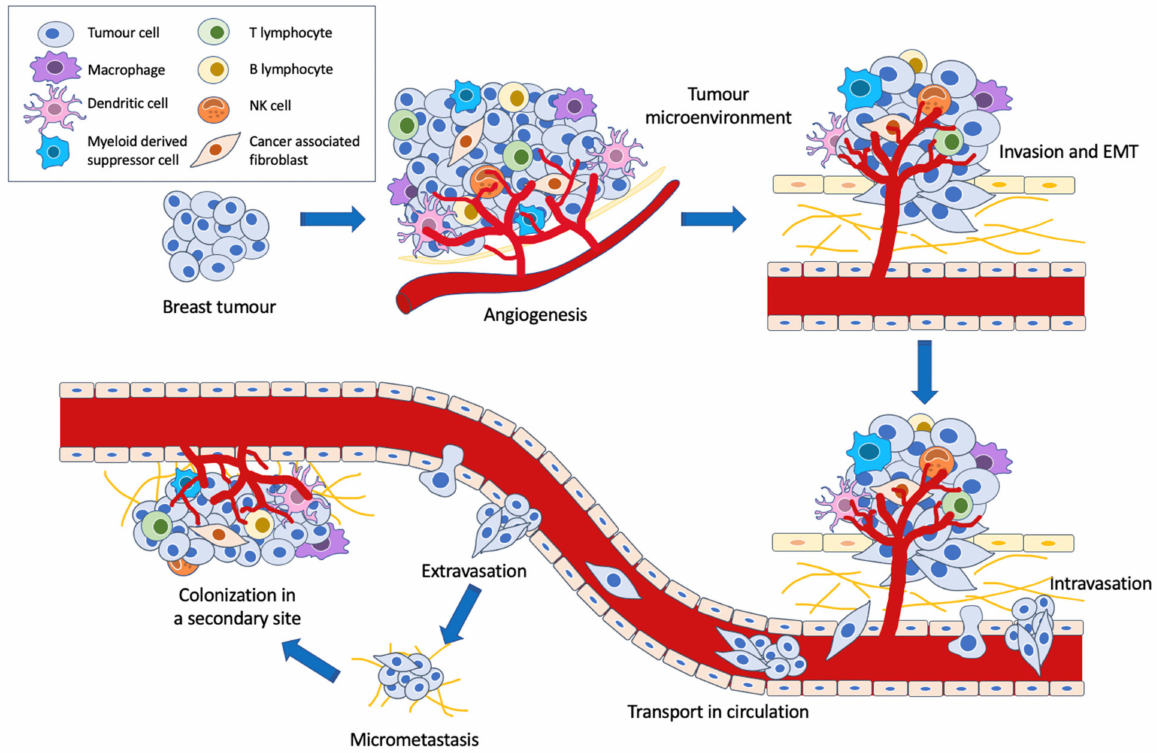
Figure 2. Metastatic cascade in